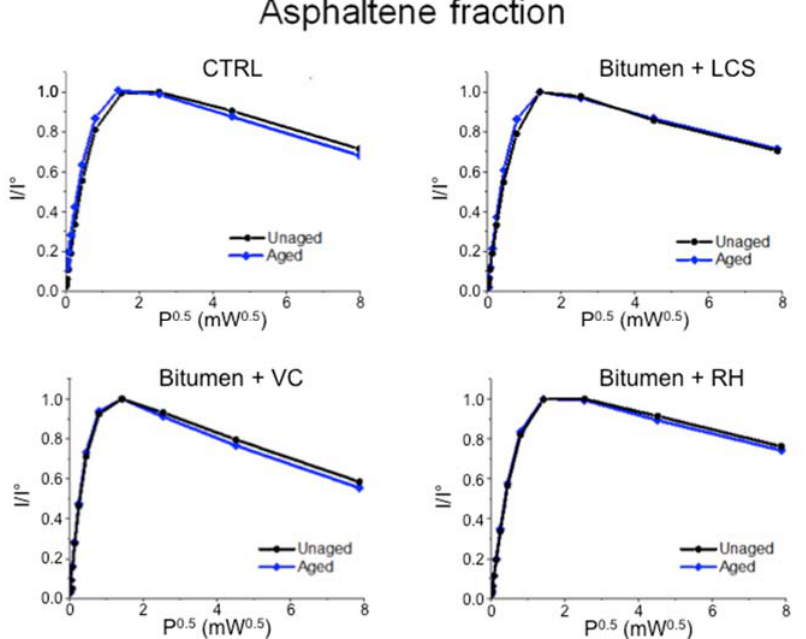
Figure 7. Power saturation profiles for asphaltene samples mixed with 2% w / w of antioxidants, as determined from the X-band EPR spectra registered at room temperature. CTRL indicates the control sample with no antioxidant added. Black lines, full circles: unaged samples; blue lines, full diamonds: samples artificially aged through the RTFOT method.